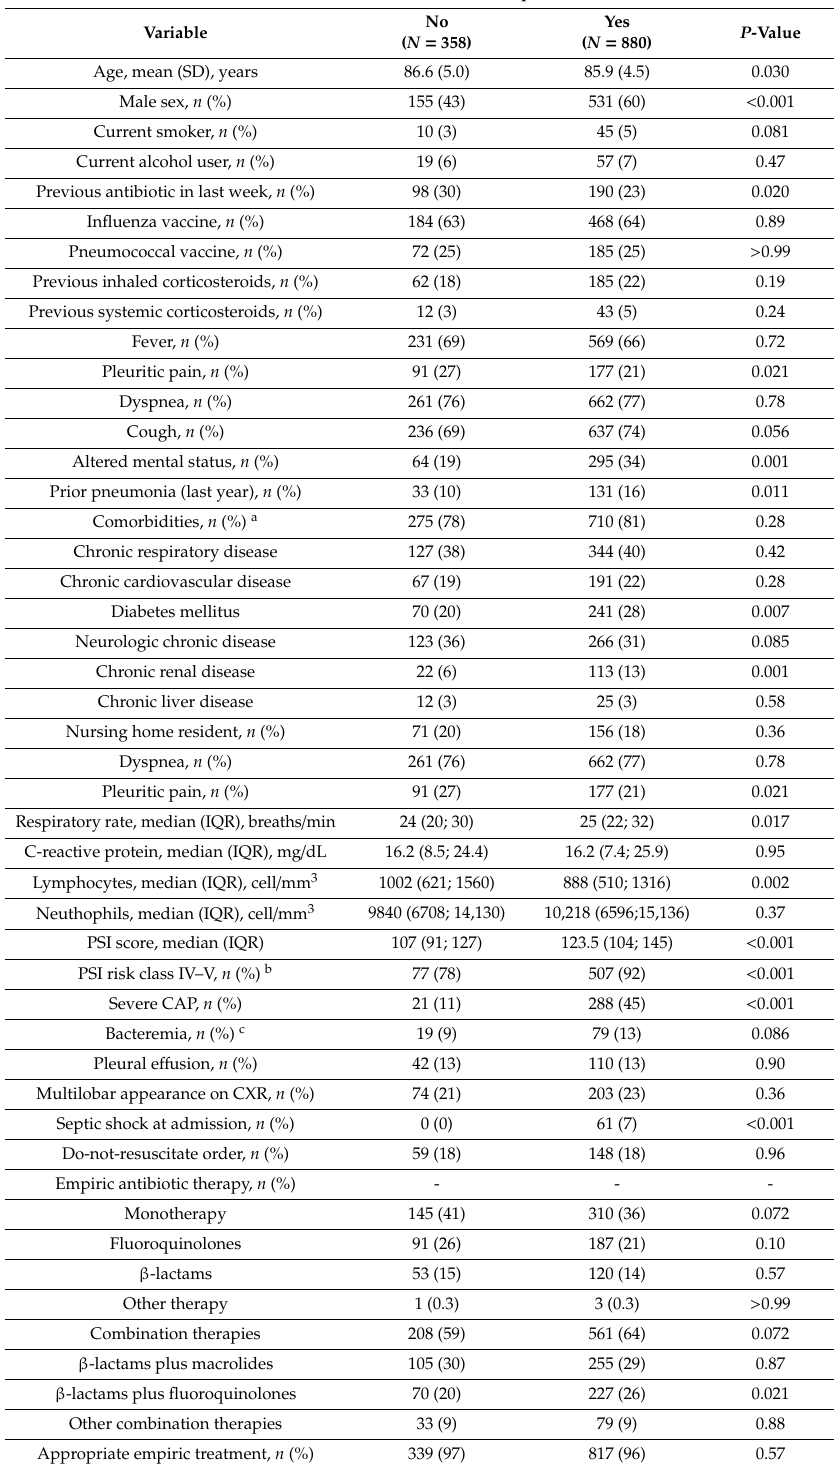
Table 1. Characteristics of very old ( ≥ 80 years) patients by the presence or absence of